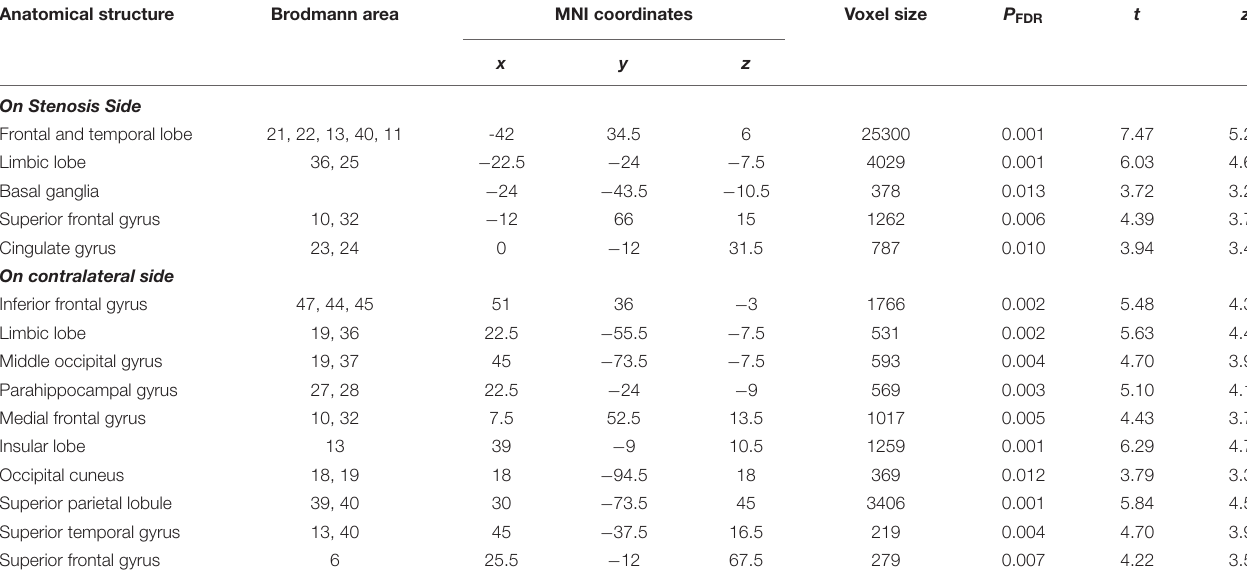
TABLE 4 | Details of gray matter regions reaching statistical significance in comparison between CAS patients and healthy controls. Anatomical structure